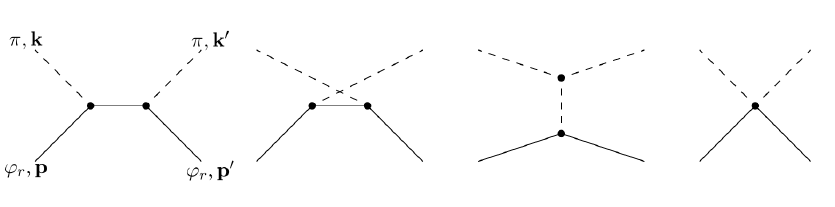
Figure 6 . Feynman diagram and notation for the roton-roton scattering process.